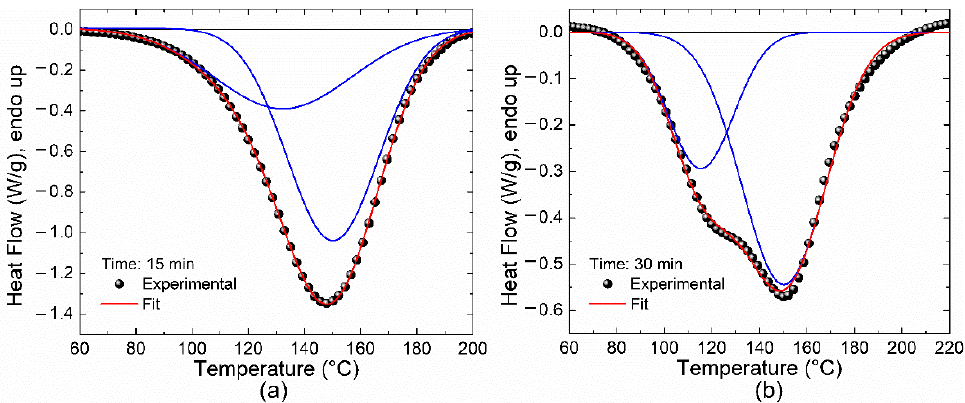
Figure 12. Non-isothermal thermograms at 10 °C/min for the Aerotuf resin cured at 110 °C for ( a ) 15 min; ( b ) 30 min. Deconvoluted curves are also shown as solid lines. 15 min; ( b ) 30 min. Deconvoluted curves are also shown as solid